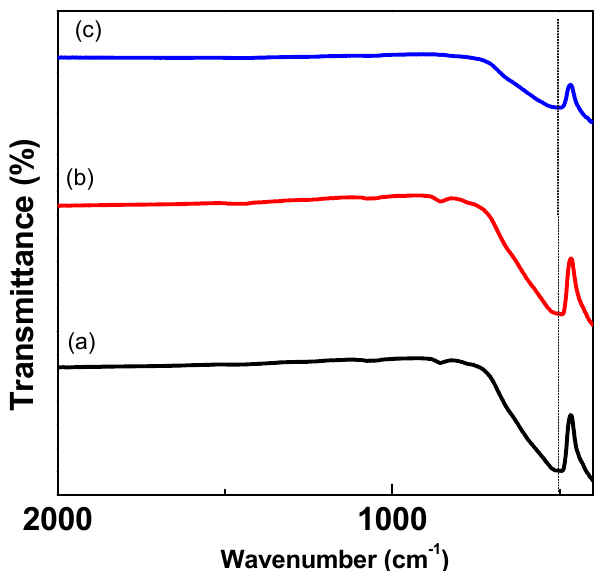
Figure 4. FTIR spectra of the BaTiO 3 ceramics sintered at ( a ) 1100 °C, ( b ) 1200 °C, and ( c ) 1300 °C.